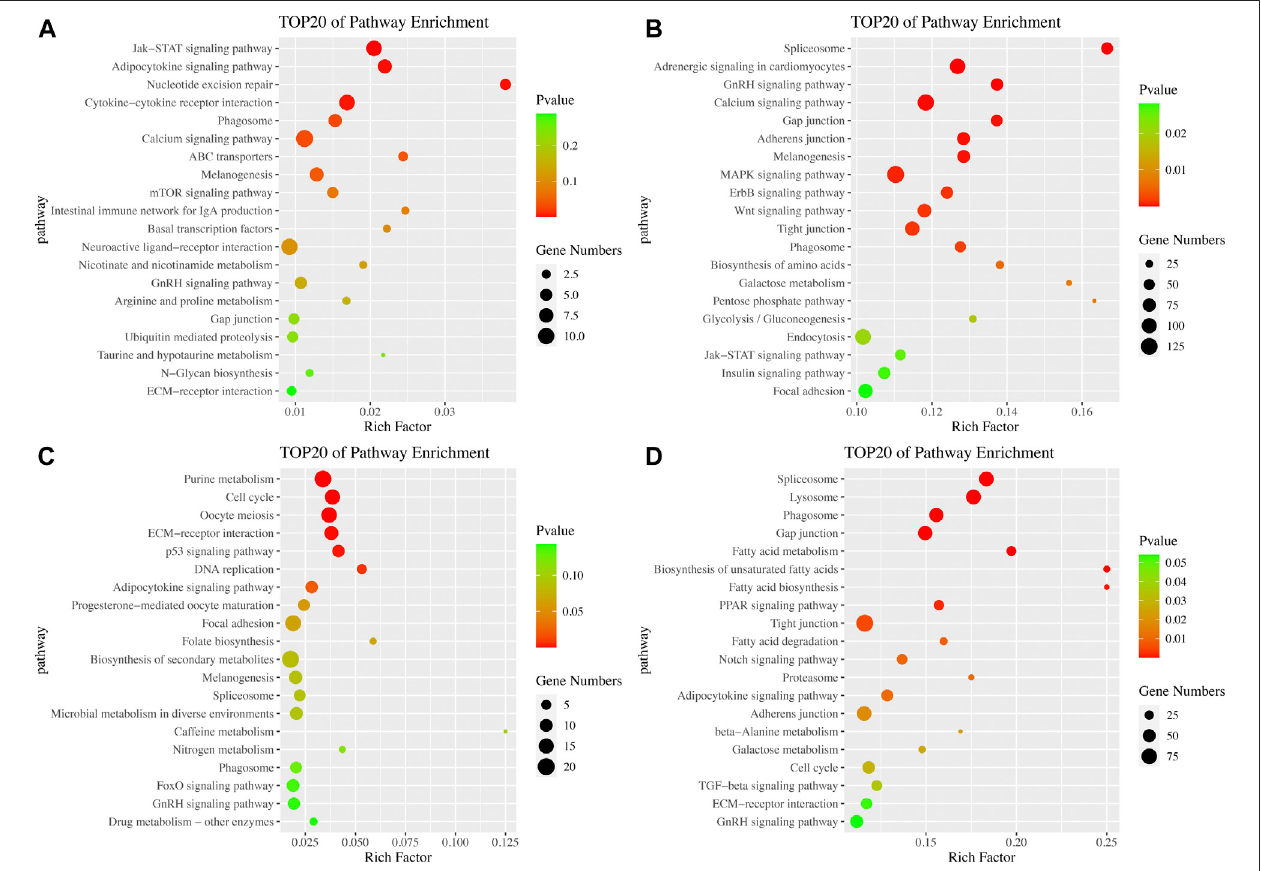
FIGURE 4 | Pathway enrichment analysis of DE mRNAs. KEGG pathway enrichment in the brain in the ovarian stages IV vs. V (A) and stages V vs. VI (B) comparison groups. KEGG pathway enrichment in the pituitary in the ovarian stages IV vs. V (C) and stages V vs. VI (D) comparison